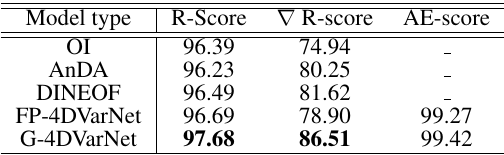
Figure 3. Space-time interpolation of SSH fields from altimeter data: the first row reports the interpolated SSH fields using nadir and SWOT wide-swath altimeter data (top left) for DUACS optimal interpolation (top center) and the proposed end-to-end learning scheme (top right). The second row depicts the associated gradient norm. The reader may refer to Fig.2 to compare the reported reconstructions with the true state.